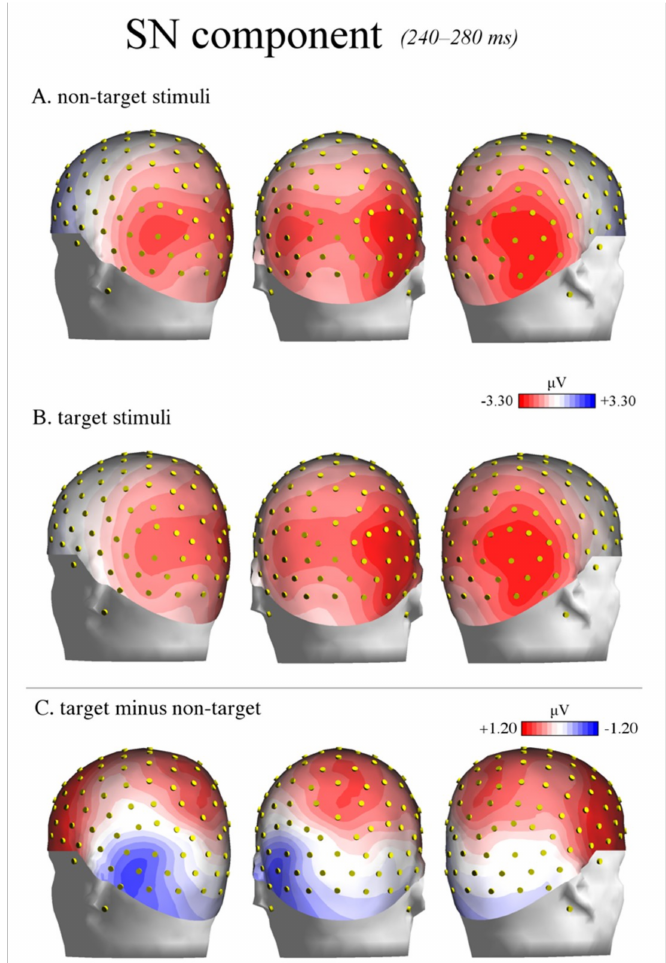
Figure 7. SN component: topographic maps. The figure illustrates the back view of the topographic maps of voltage distribution in the SN time window (240–280 ms) relative to non-target stimuli ( A ), target stimuli ( B ), and the di ff erence wave target minus non-target ( C ). The positive values are represented in red, while the negative values are represented in blue. A strong left-lateralized negative peak is visible at occipito-temporal sites ( C